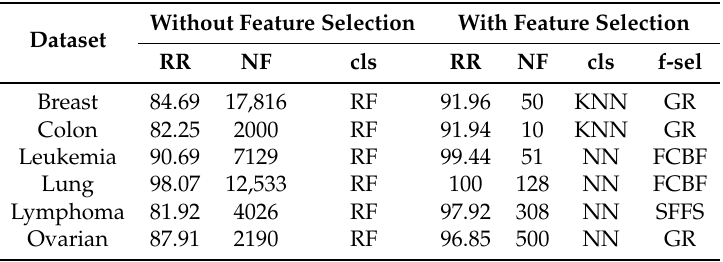
Table 10. Summary of the best